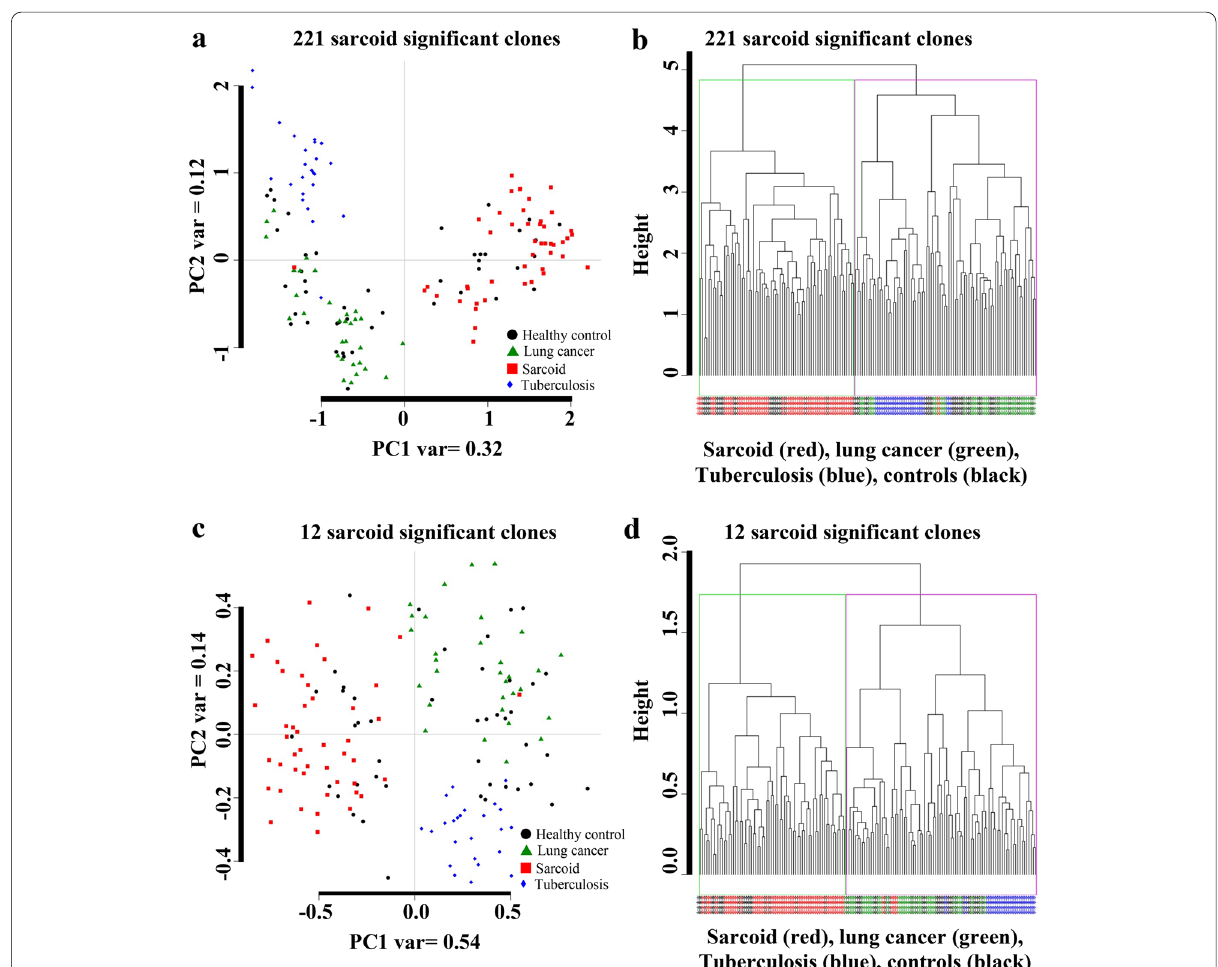
Fig. 3 PCA and Hierarchal clustering (option 2). a PCA plot along PC1 and PC2 generated with 221 clones (FDR 0.01) of the four groups: (1) healthy control samples; (2) Sarcoidosis samples; (3) TB samples; and (4) Lung cancer. The PC1 explains a variance of 32%, while the variance along the